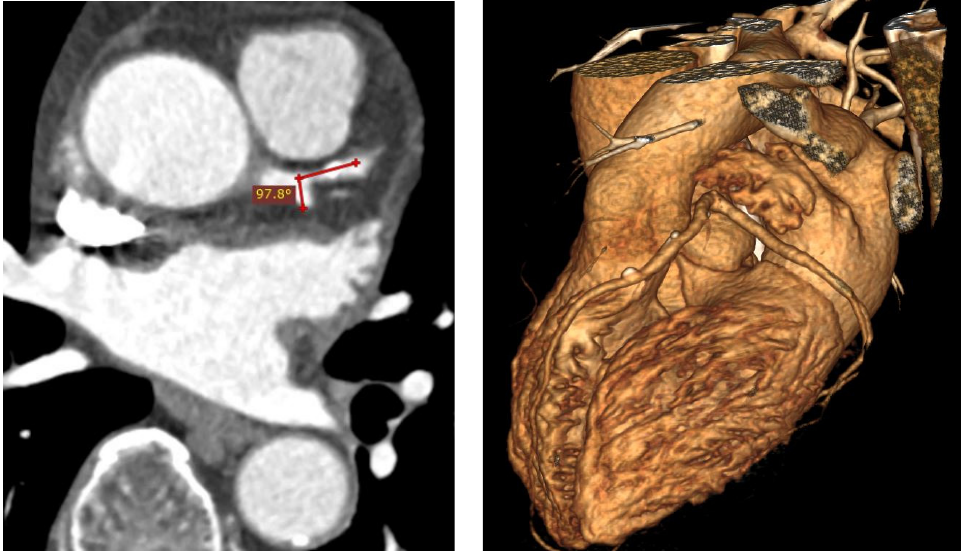
Figure 2. Wide LAD-LCx angle in a 68-year-old man with multiple calcified plaques at the LAD resulting in significant stenosis. The LAD-LCx angle was measured 97.8° on 2D axial image ( left image) and 103.5° on 3D volume rendering ( right image), respectively.